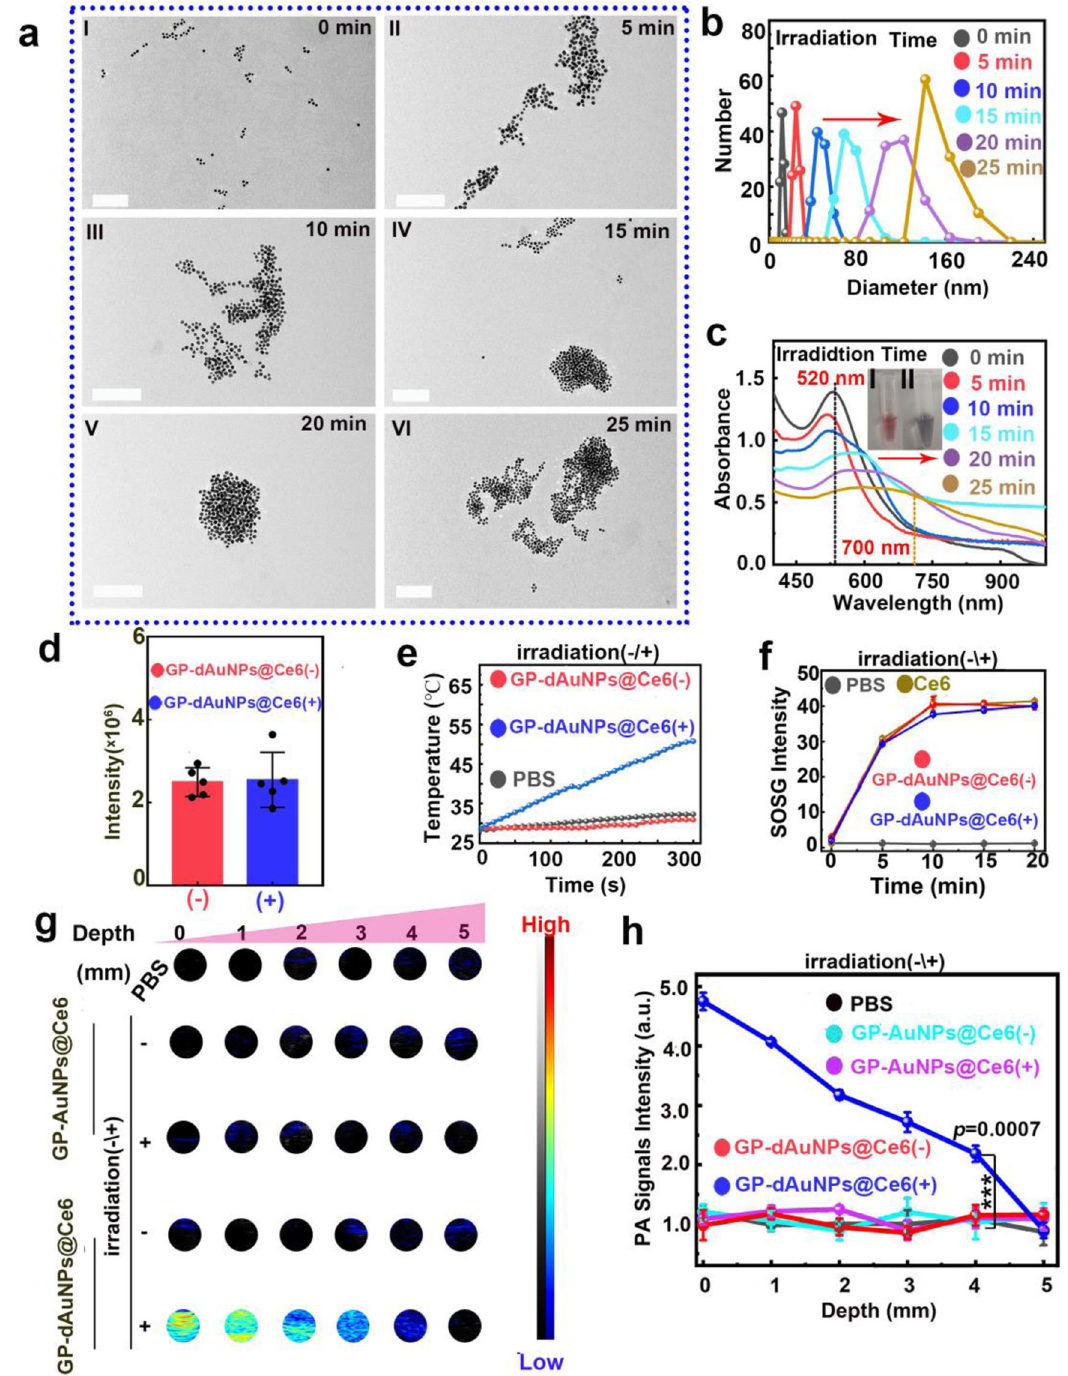
Fig. 2 Schematic and characterization of nanoprobes of GP-dAuNPs@Ce6. a Irradiation time-dependent TEM images of GP-dAuNPs@Ce6 (405 nm, 1.0 W cm − 2 ). Scale bars, 200 nm. b Corresponding irradiation time-dependent hydrodynamic size pro fi les of GP-dAuNPs@Ce6 (405 nm, 1.0 W cm − 2 ). c Corresponding irradiation time-dependent absorption spectra of GP-dAuNPs@Ce6 (405 nm, 1.0 W cm − 2 ). d Fluorescence intensity of 0.5 mg mL − 1 GP- dAuNPs@Ce6 with ( + ) and without laser irradiation ( − ). e The photothermal heating curves of PBS, non-aggregated GP-dAuNPs@Ce6 and aggregated GP-dAuNPs@Ce6 under the irradiation of 808-nm laser. f Evaluation of 1O 2 generation by PBS, free Ce6, non-aggregated GP-dAuNPs@Ce6 and aggregated GP-dAuNPs@Ce6 by using the SOSG assay. The concentration of Ce6 in each group is 25 µ g mL − 1 . g Chicken breast tissue thickness- dependent photoacoustic signals of 1.0 mg mL − 1 GP-dAuNPs@Ce6 or GP-dAuNPs@Ce6 with ( + ) and without laser irradiation ( − ), h Corresponding plots of photoacoustic intensity versus chicken breast tissue thickness ( p = 0.0007). All imaging experiments were repeated three times with similar results. Statistical analysis was performed using a one-way ANOVA analysis. Error bars represent the standard deviation obtained from three independent measurements (*** means p < 0.001, n = 3). Data are presented as mean values ± SD. Source data are provided as a Source Data fi